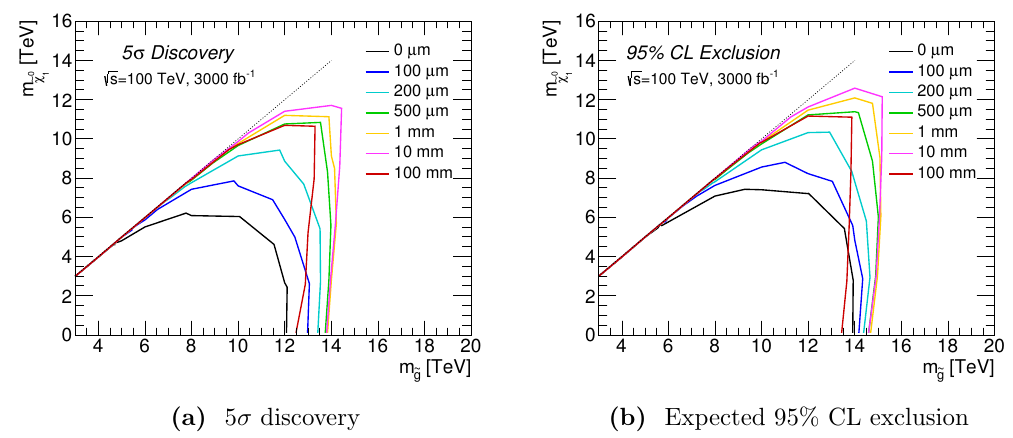
Figure 24. Same as in (cid:12)gure 23, but for an integrated luminosity of 3000 fb (cid:0) 1